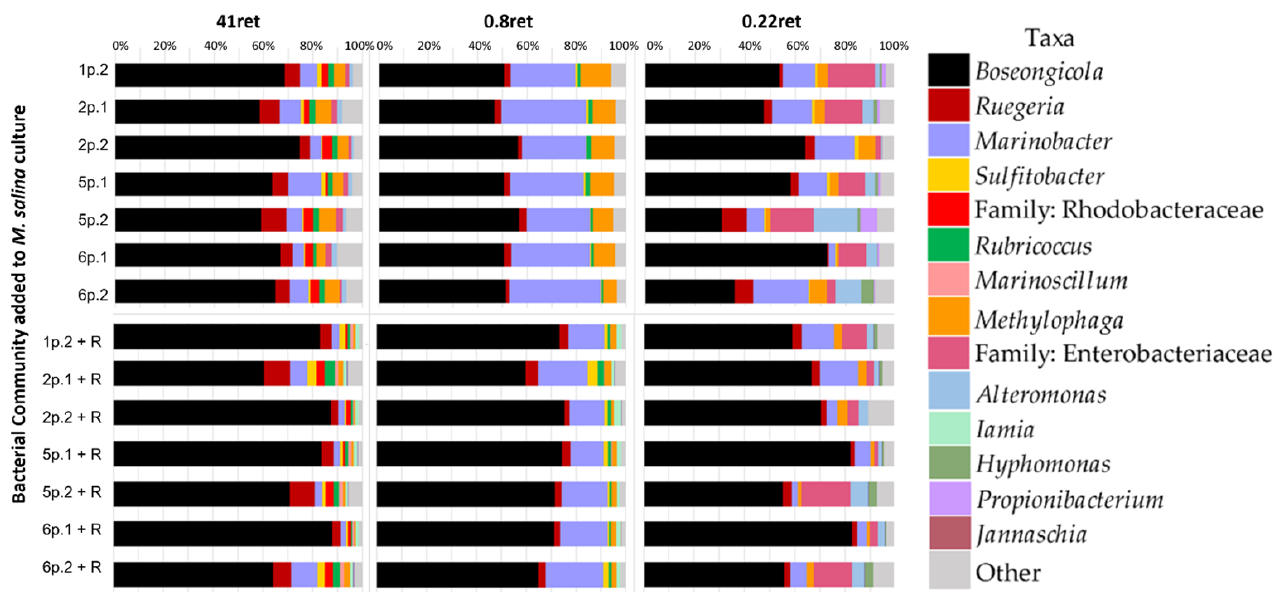
Figure 2. Averaged stacked bar graph of the bacterial OTUs present in different fractions in the absence (top) and presence (+R, bottom) of B. plicatilis . Taxonomy is shown at the genus level unless otherwise stated. Bacterial OTUs <1% of the total abundance is categorized in ‘Other’ (grey).